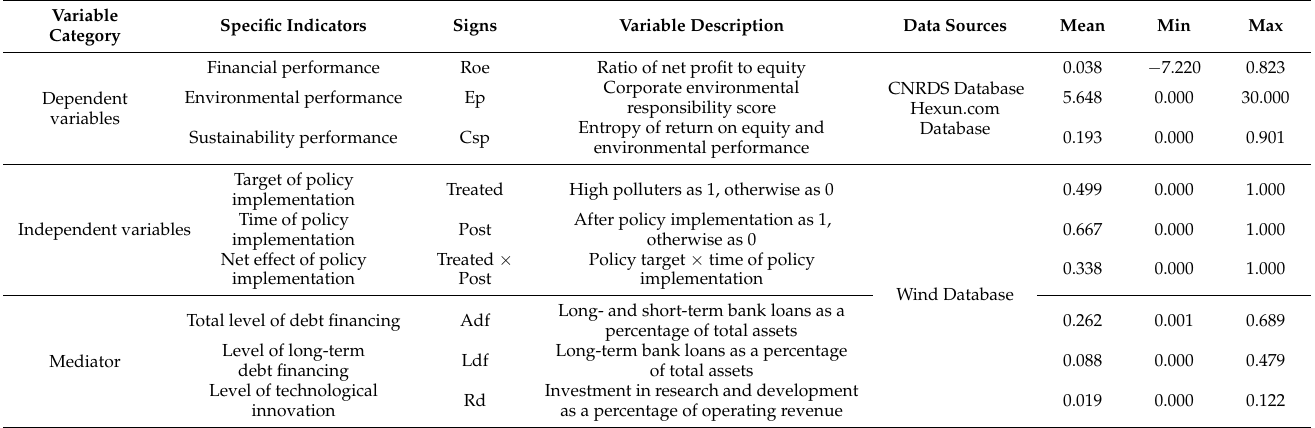
Table 1. Variable definition and